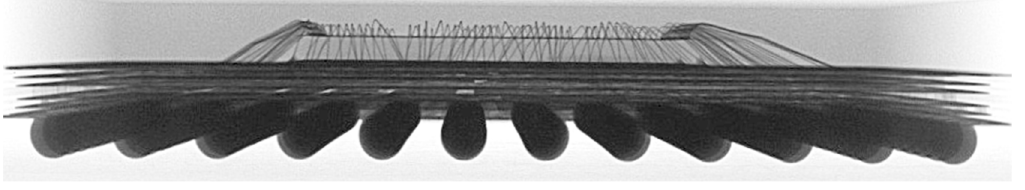
Figure 2. Side view X-ray image of the AD9361 [4].